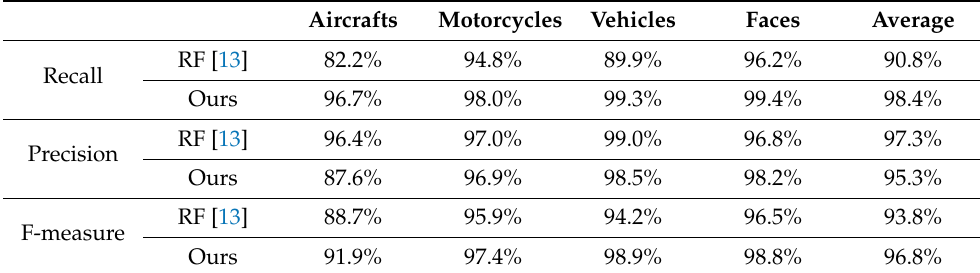
Figure 26. ORF 1 approaches the same error as RF. Table 9. Comparison result of our research with RF 1 in Caltech